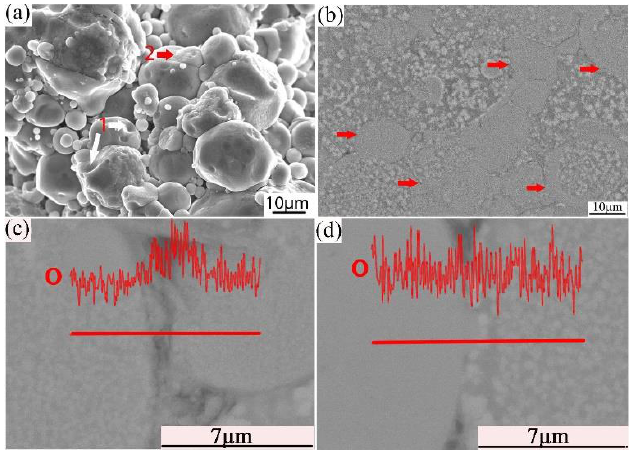
Figure 13. SEM/SE micrograph of the fracture surface ( a ) cross section ( b ); EDS line scan of O in the particle boundary ( c ); and EDS line scan of O in the deformed particle boundary ( d ) of the green with a compaction velocity of 9.4 ms −1.